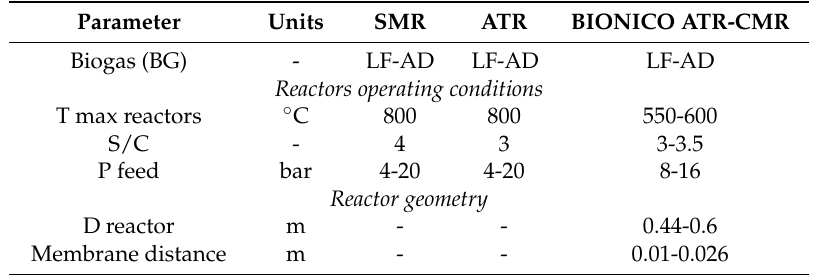
Table 2. Sensibility analysis: design parameters. SMR: steam reformer; ATR: autothermal reformer; CMR: catalytic membrane